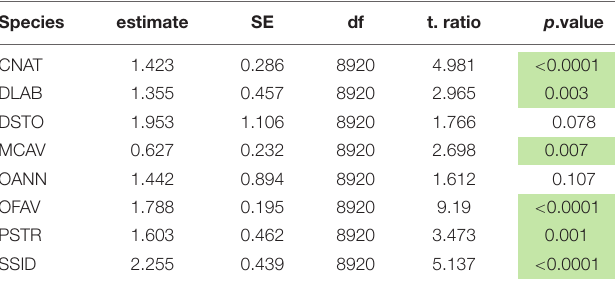
TABLE 6 | Tukey-adjusted pairwise comparisons ( p-values ) of “no active disease” (NAD) rates between inshore and offshore sites for eight coral species using the best approximating model.